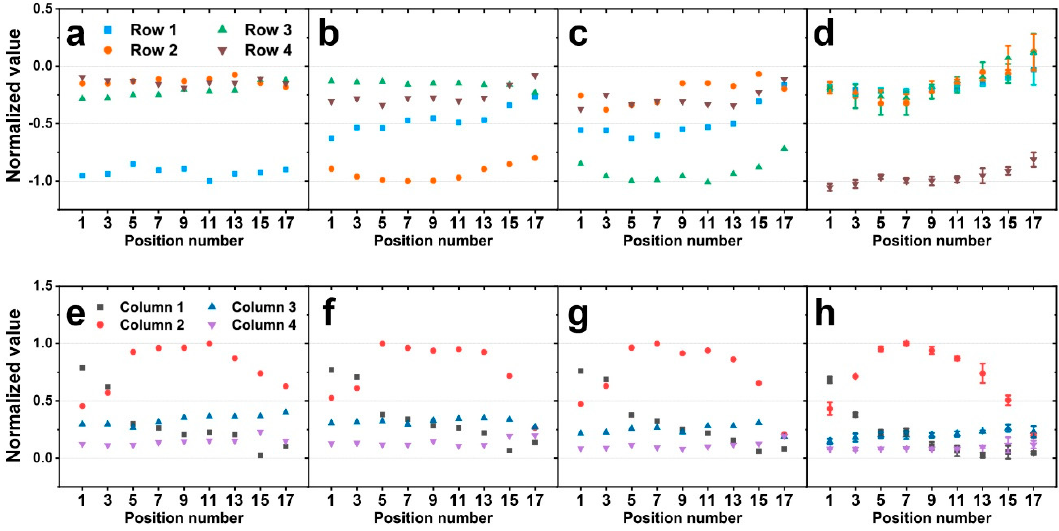
Figure 10. Experimental results of the normalized value from the output voltages of a sensor ( a , e ) when 5 N of force was applied to row 1, ( b , f ) when 5 N of force was applied to row 2, ( c , g ) when 5 N of force was applied to row 3, and ( d , h ) when 5 N of force was applied to row 4. The graphs above show the response of the row sensors, and the graphs below show the response of the column sensors. In ( d , h ), the error bars are standard deviations.